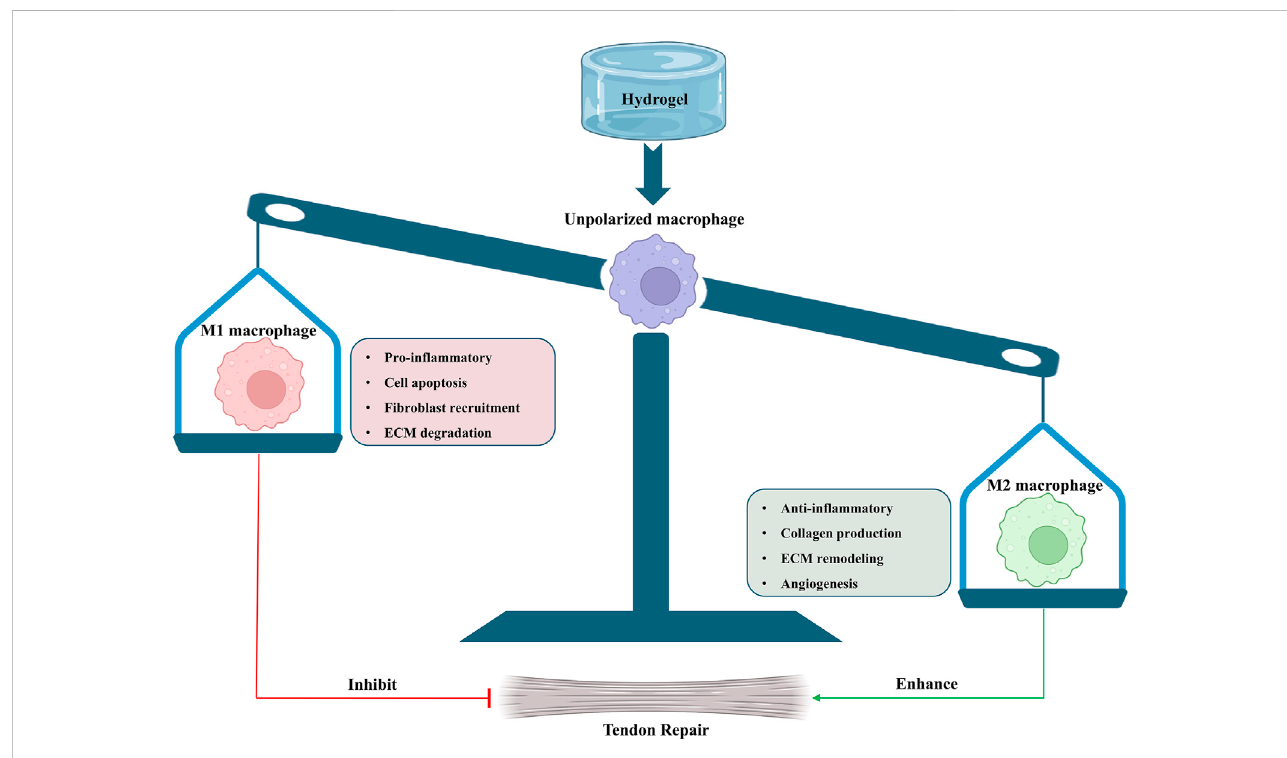
FIGURE 5 Effects of functionally-adapted hydrogels on macrophage polarization in tendon repair.